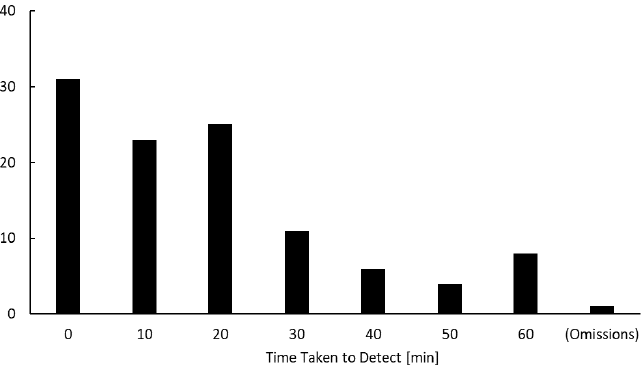
Figure 4. Histogram of the time taken by the proposed method using all parameters to detect a fire after it has occurred, at 10 min intervals.